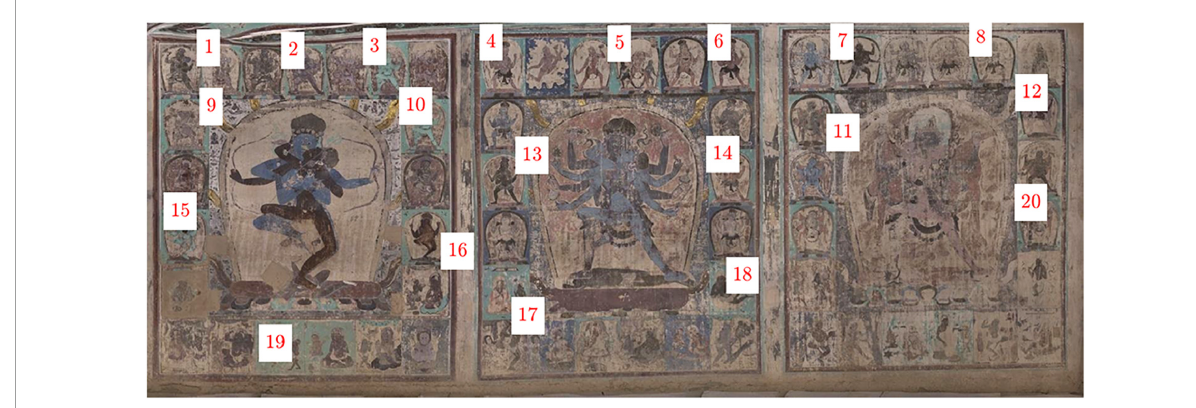
FIGURE9 Coordinates of selected reference samples in the mineral green areas.